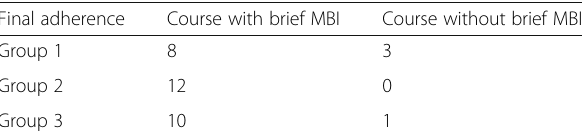
Table 2 Final adherences between courses with and without brief MBI Final adherence